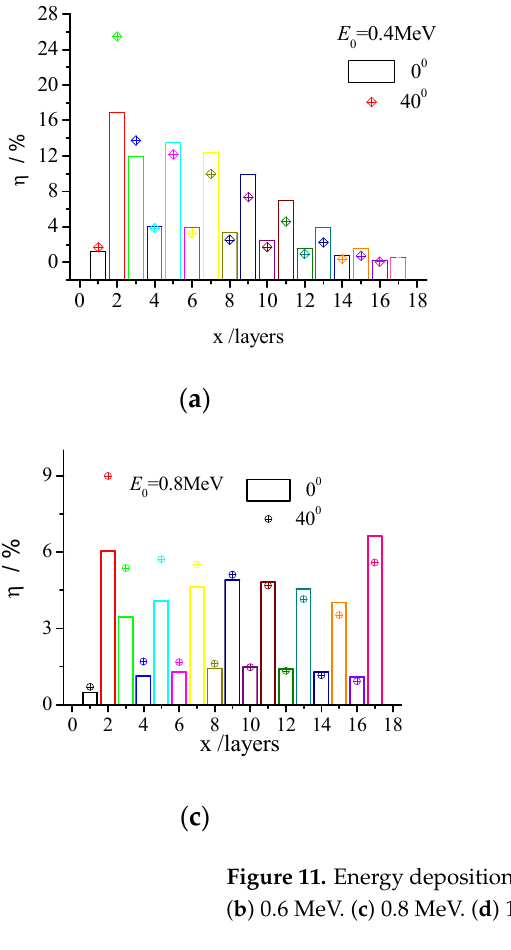
Table 2. Total energy deposition rate in the multilayer